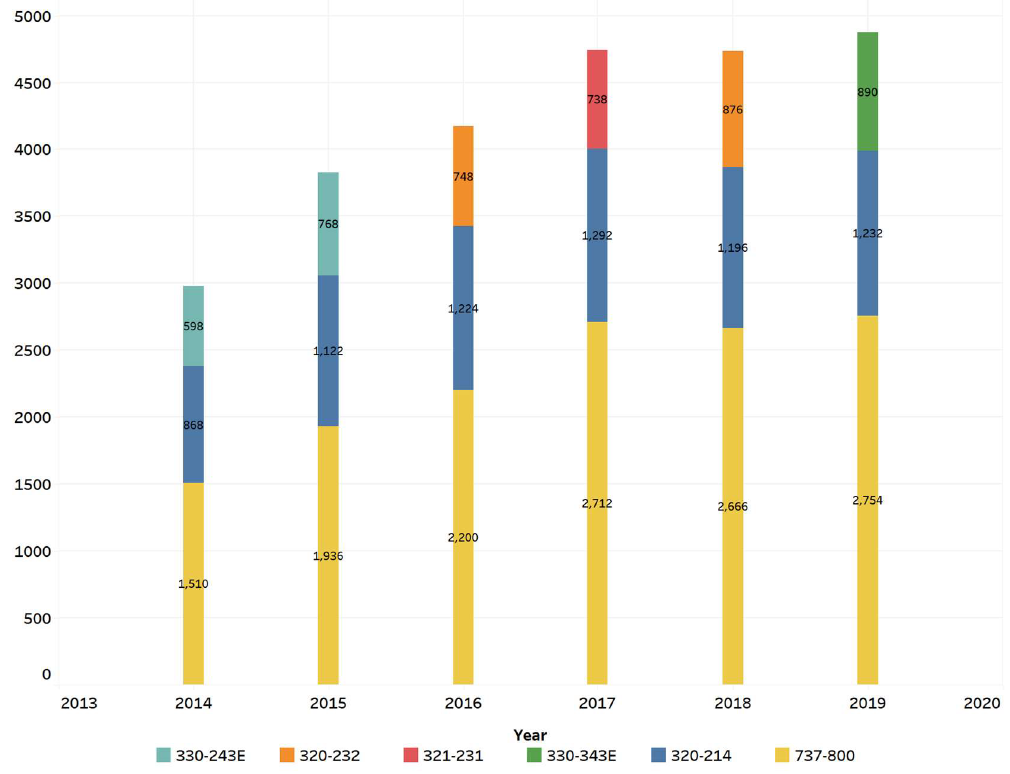
Figure 2. Statistical characteristics of aircraft configuration during 2014–2019.